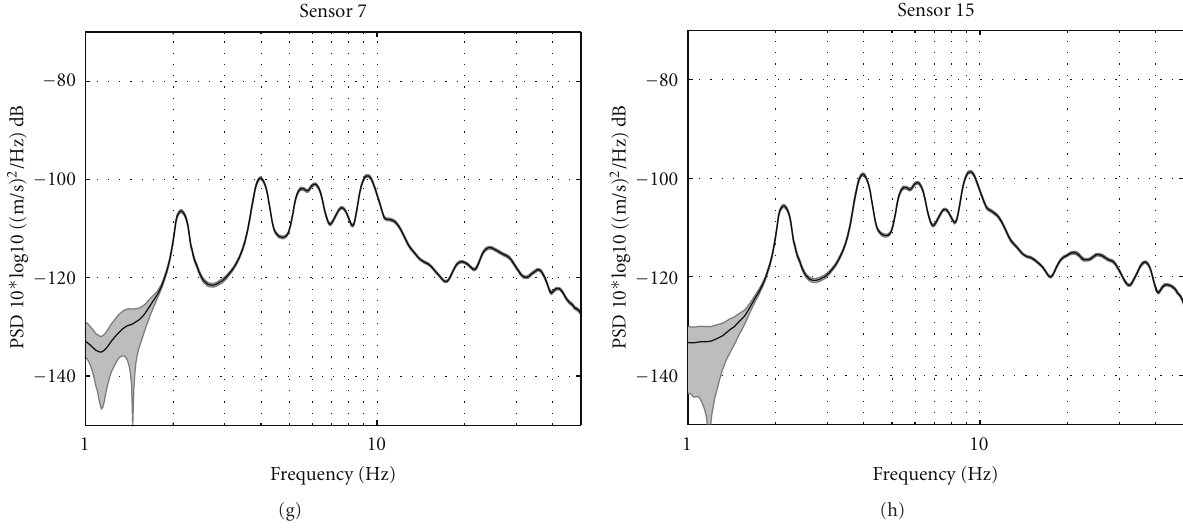
Figure 4: Same as Figure 3, but for the transversal